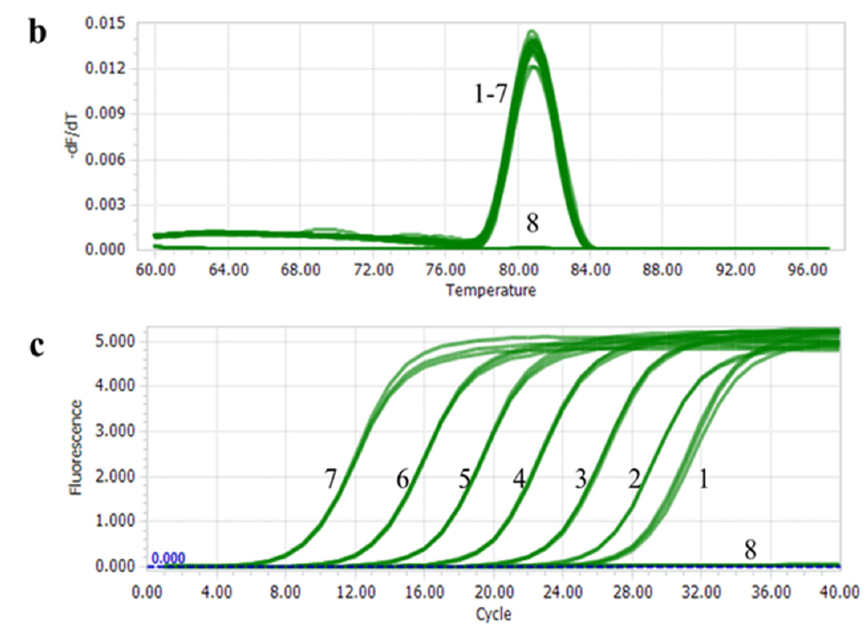
Figure 1. Amplification of the standard sample. ( a ) Standard curve of PTP2-qPCR. ( b ) Melting peaks of PTP2-qPCR. ( c ) Amplification curves of PTP2-qPCR. 1–7: 1.0 × 10 1 to 1.0 × 10 7 copies/µL standard plasmids. 8: water.